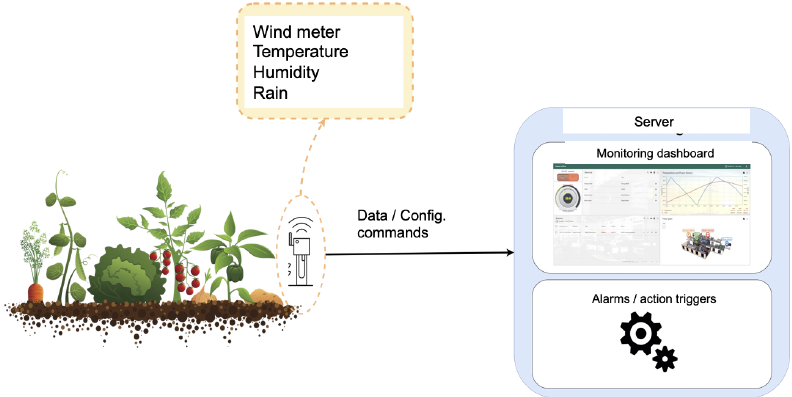
Figure 1. System